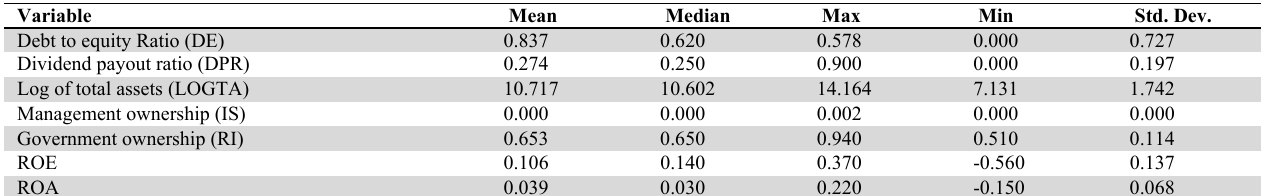
Summary statistics